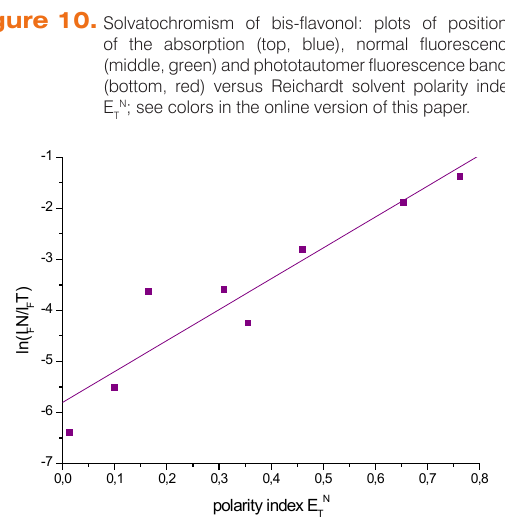
Figure 11. Normal-to-phototautomer emission intensity logarithm plot versus a solvent